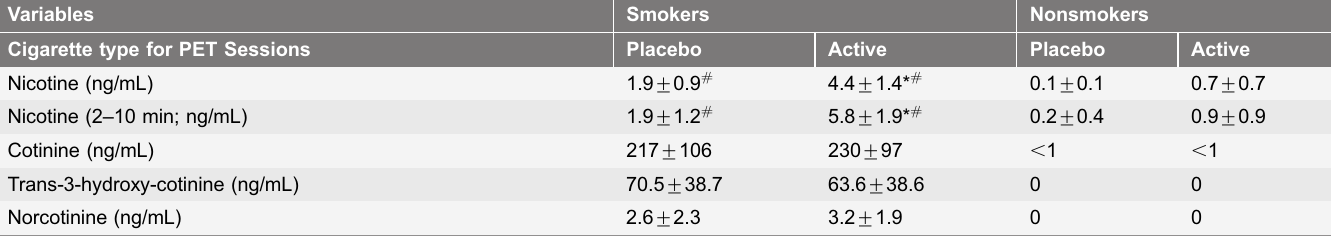
Table 2. Concentrations of nicotine and metabolites in plasma during active and placebo cigarette